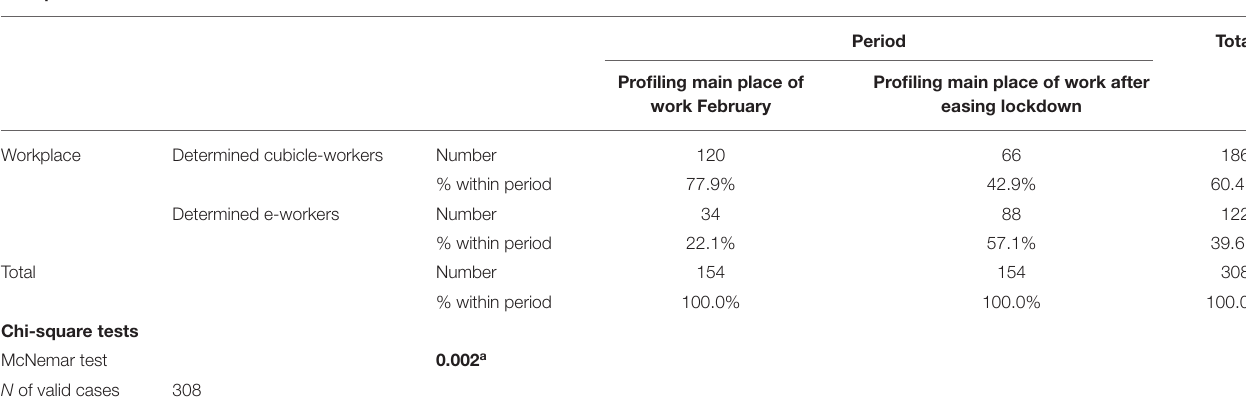
TABLE 7 | Workplace * Period Cross-tabulation and Chi Square